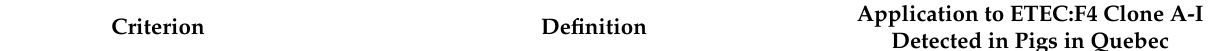
Table 1. Definition of criteria for determination of a high risk bacterial clone for antibiotic resistance dissemination in the context of the One Health